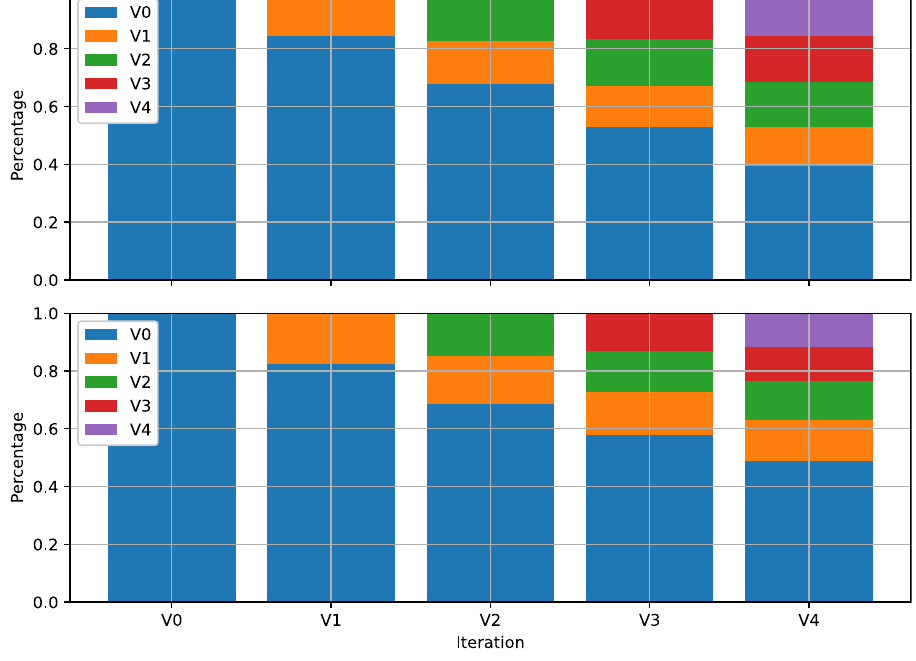
Fig. 2 Evolution of trees in the DR dataset. Update metrics on top, no update